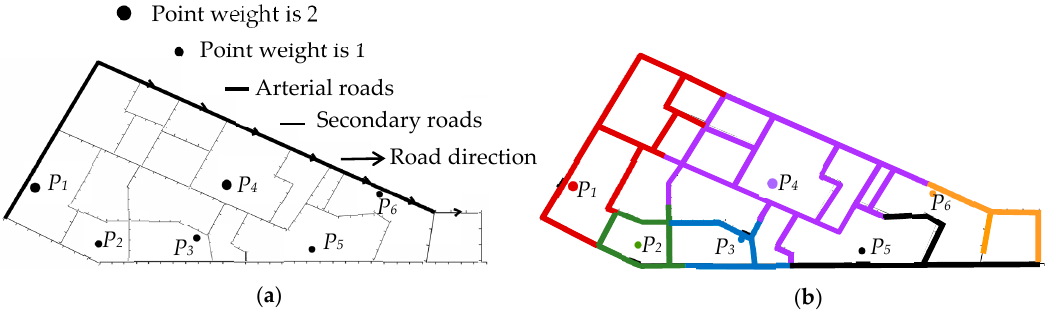
Figure 6. Construction of weighted network Voronoi diagram: ( a ) initial point cluster and road network and ( b ) weighted Voronoi diagram of point cluster.